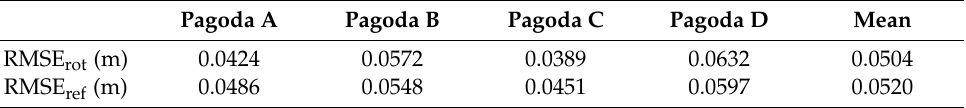
Table 6. Root-mean-squares error (RMSE) of the iterative closest point (ICP) matching for the symmetry analysis.